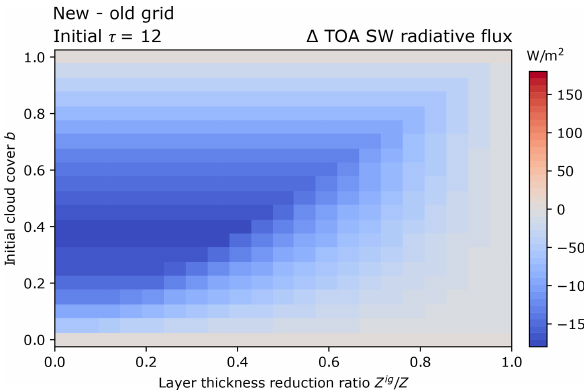
Figure A1. Change in short-wave (SW) radiative flux due to the application of SC-VOLUME cloud squeezing for a cloud with an initial τ = 12, varying initial cloud cover values as on the y axis, and varying thickness reduction ratios as on the x